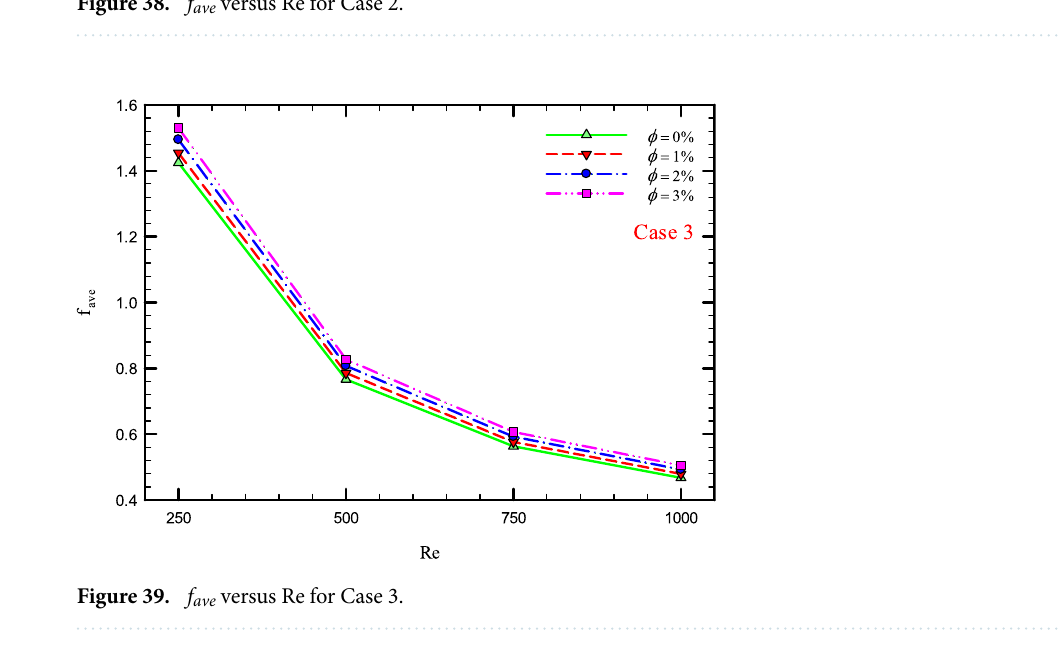
Figure 38. f ave versus Re for Case 2.